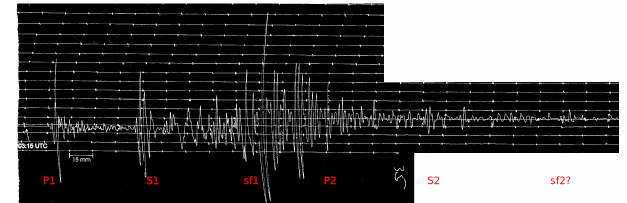
Figure 6. Scanned analogue seismogram from the original smoked paper of the first earthquake on 9 July 1956. The Z component of the 1300kg Wiechert seismograph at the station GTT is at about 2073km distance from the epicenter. Body waves ( P 1, S 1) and surface waves (sf1) of the first earthquake are recorded in high quality. The recording is clipped at the largest amplitude of the recording and following signals are recorded with an offset of 5– 10mm. Theoretically calculated phase arrivals (P2, S2, sf2?) show that the waveform of the second earthquake is hidden by the surface waves of the first earthquake. Component polarity is inverse to the real ground motion. (“Up” on the seismogram recording represents “down” in real ground motion.)